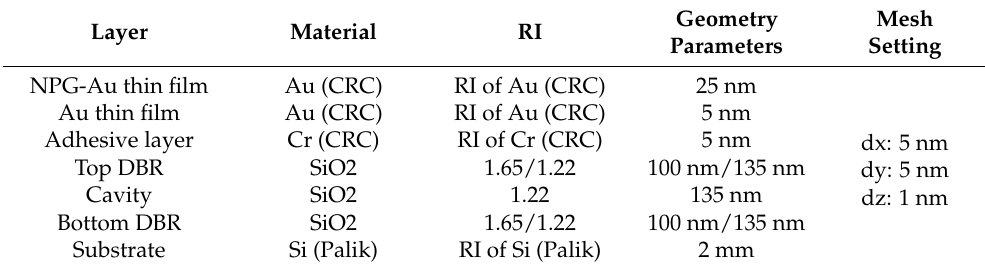
Table 1. Simulation